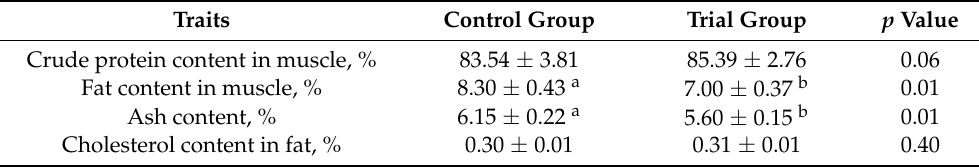
Table 6. Amino acid profile of M. longissimus thoracis et lumborum according to pork group. Items Control Group Trial Group Aspartic acid (Asp)